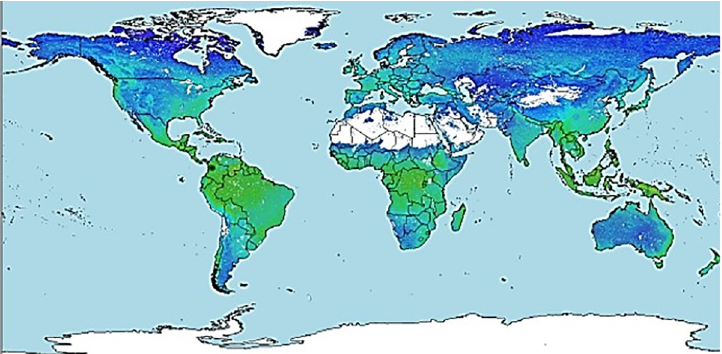
Fig 2. Global-scale environmental layer using WorldClim. Colors indicate the mixture of BIO1, BIO8, BIO12, BIO13, BIO14, VI, Slope, Altitude, TH24, PP for each zone in a range of 5’x5’ cell resolution. Green indicates areas of potential presence of Diatraea spp. and blue indicates areas whose environmental conditions do not guarantee insect´s life cycle.